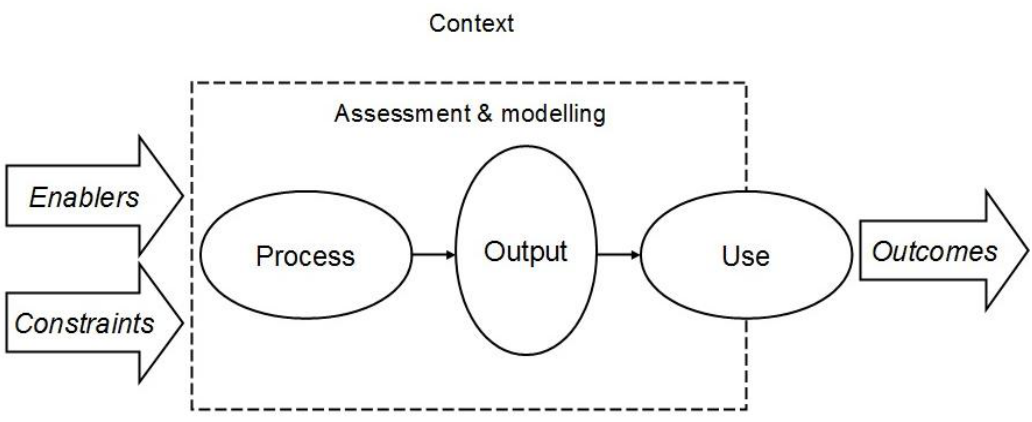
Figure 1. Assessment and modeling in interaction with their societal context (influenced e.g., by